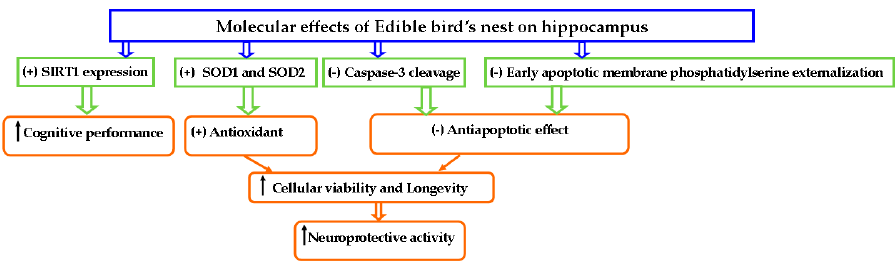
Figure 3. The molecular mechanism underlying the neuroprotective effects of EBN. (+): stimulation or upregulation, (-): inhibition or attenuation. SOD1 and SOD2: genes of superoxide dismutase, Upward arrow: enhance.